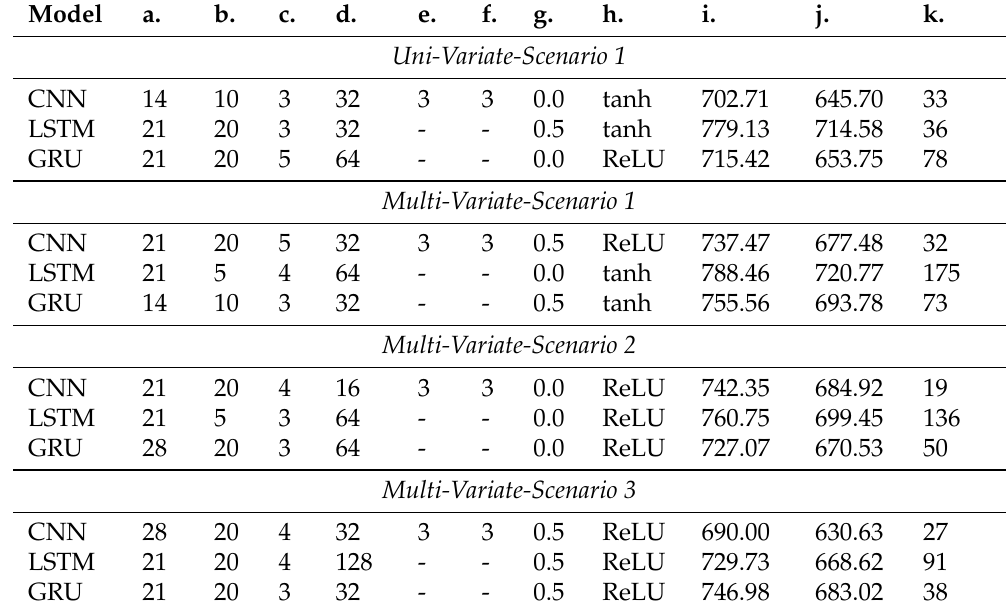
Table 7. Best results, per scenario, for Method 1. The letters stand as follows: a. timesteps; b. batch size; c. number of layers; d. number of neurons/filters; e. pool size; f. kernel size; g. dropout;